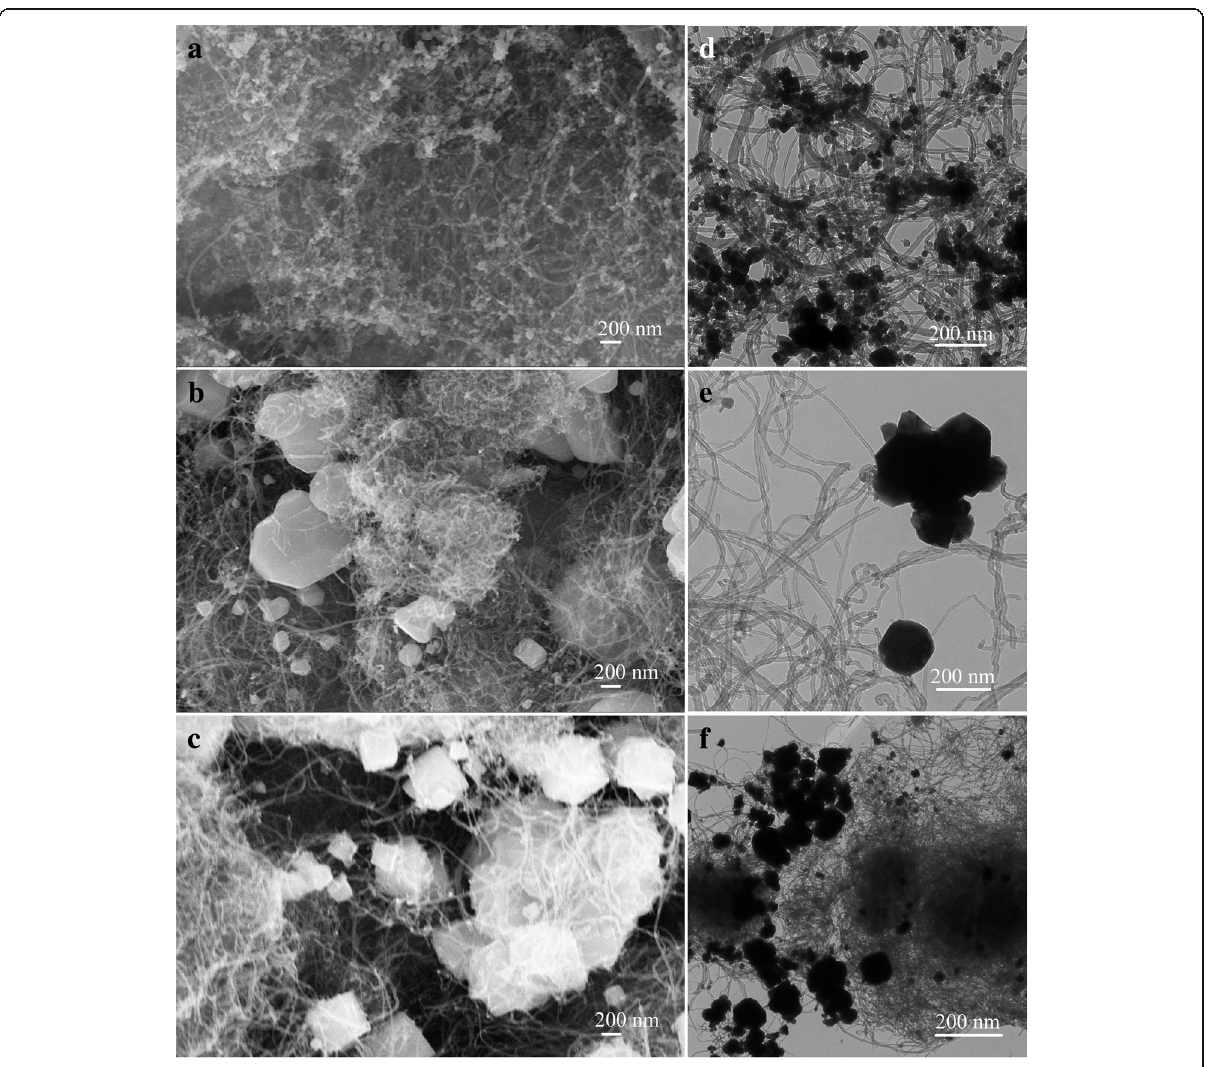
Fig. 1 SEM and TEM images of the synthesized CNT-Cu 2 O nanocomposites. a , d CNT-Cu-30-1. b , e CNT-Cu-60-1. c , f